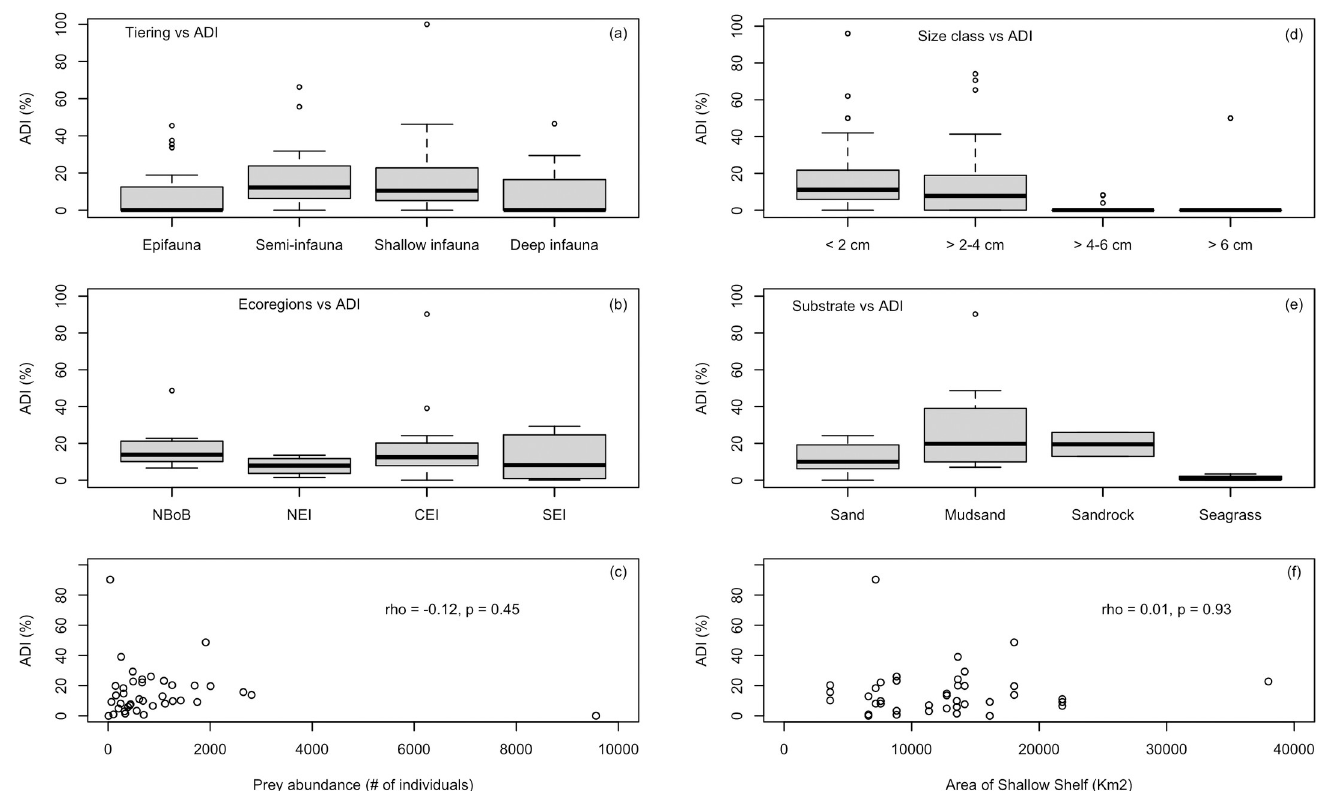
Fig 2. Variations of assemblage drilling intensities (ADI) on molluscs among different environmental subcategories (i.e., tiering (a), ecoregions (b), size class (d), substrate (e), prey abundance (c)) and with the area of the shallow shelf (f). Ecoregions: NBoB = Northern Bay of Bengal, NEI = North-East India, CEI = Central- Eastern India, SEI = South-Eastern India.